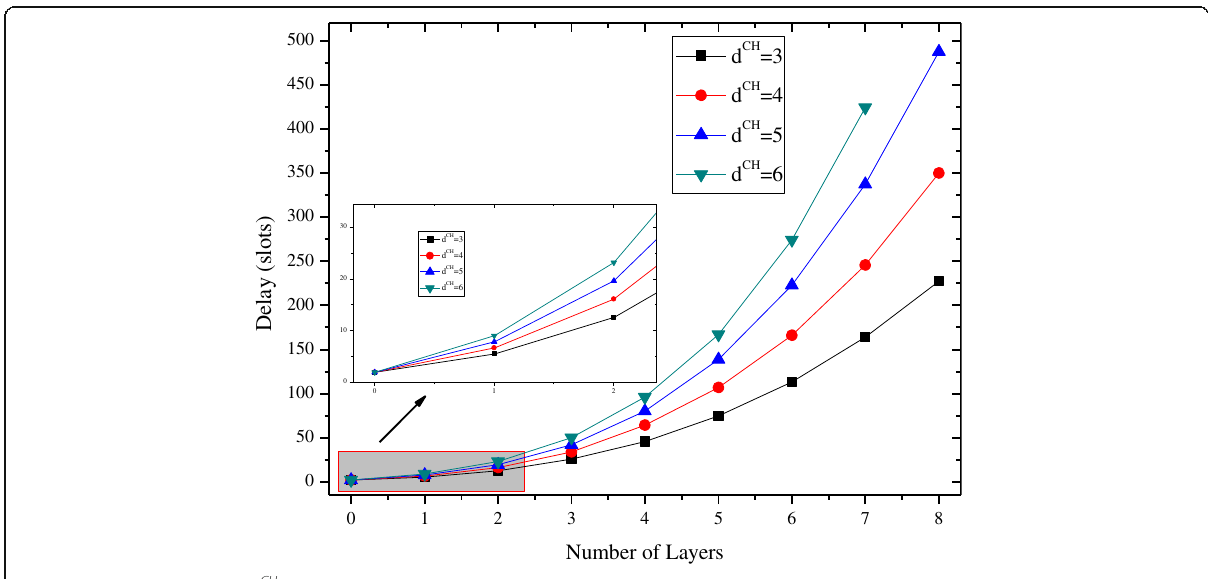
Fig. 10 Delay with different d